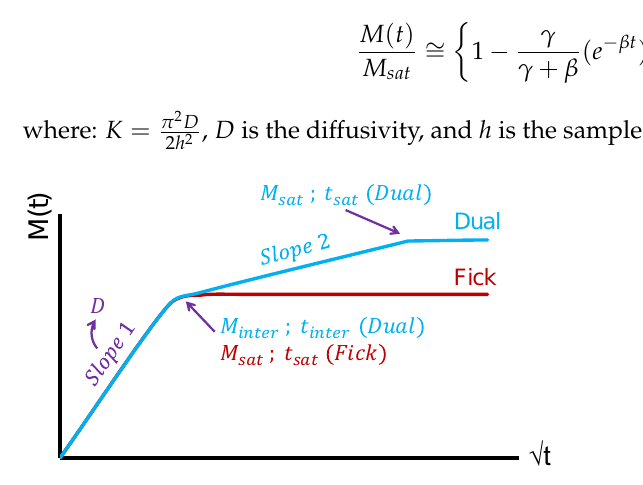
Figure 1. Fick and two-step (Dual) diffusion curves, positions of M sat , t sat , M inter and t inter .